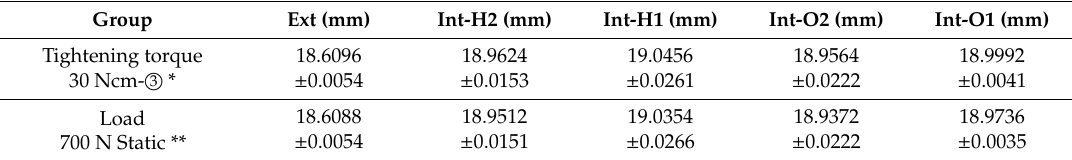
Table 2. Mean total lengths and standard deviations of the implant-abutment specimens before and after 700 N static loading.